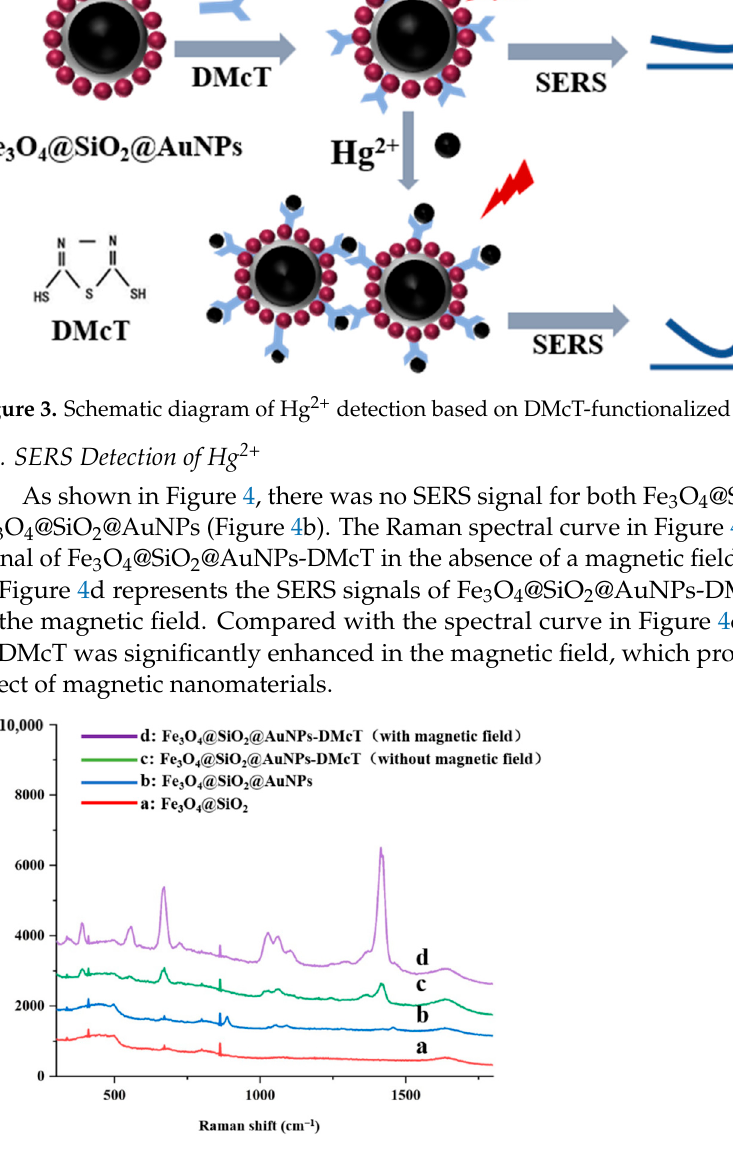
Figure 4. Raman spectra for different substrate states. ( a ): Fe 3 O 4 @SiO 2 , ( b ): Fe 3 O 4 @SiO 2 @AuNPs, ( c ): Fe 3 O 4 @SiO 2 @AuNPs-DMcT without magnetic field, and ( d ): Fe 3 O 4 @SiO 2 @AuNPs-DMcT with the magnetic field.